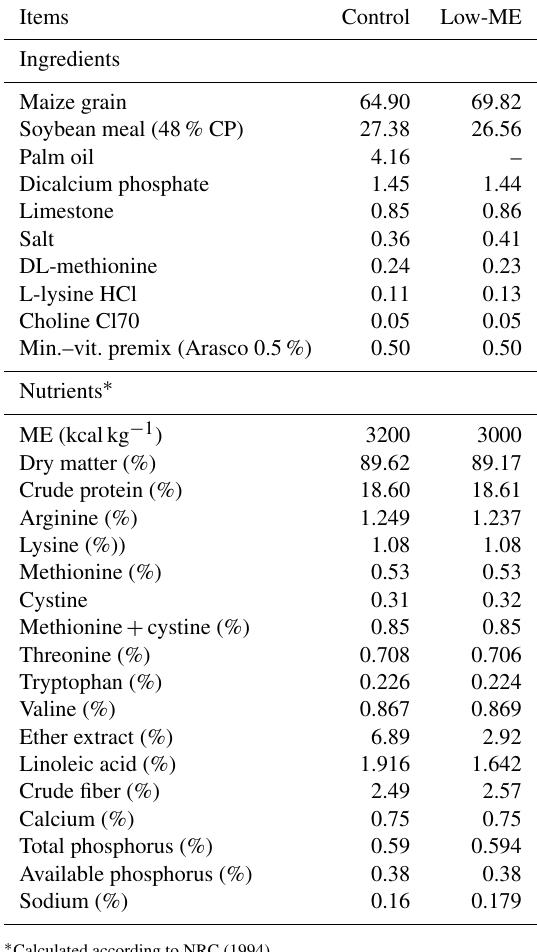
Table 1. Ingredients and composition of diets fed to broiler chick- ens. (Min.–vit. premix refers to “mineral–vitamin